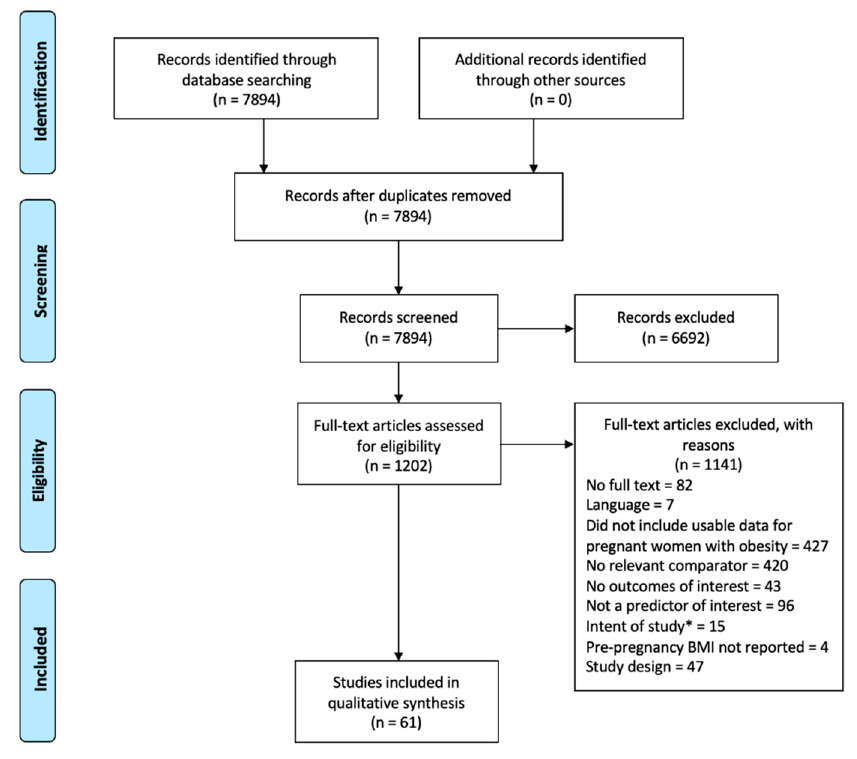
Figure 1. PRISMA. * Intent of study indicates that the objective of the study was not to study the predictors of adverse pregnancy outcomes. Table 1. Overview of Included